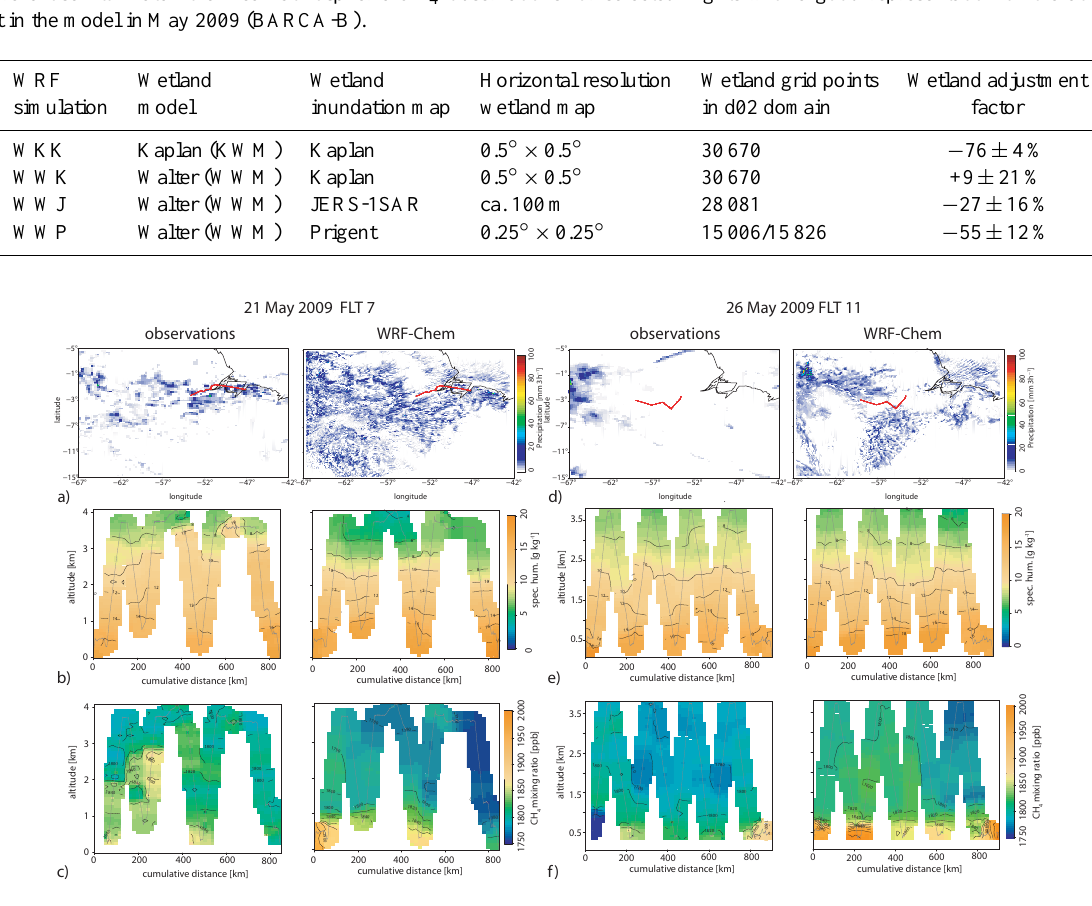
Fig. 6. Comparison between observations and WRF model output for two case studies during BARCA-B (FLT 7 from Santar´em to B´el´em on 21 May 2009 18:00–21:00UTC – left panel and FLT 11 from Manaus to Santar´em on 26 May 2009 13:00–16:00UTC – right panel). On the left side of each panel the observations (TRMM for precipitation (a, d) , specific humidity and CH 4 from airborne observations (b, c, e, f) ) are shown while on the right panel the WRF-GHG simulation output of WWP using the Walter wetland model and the Prigent wetland inundation map is